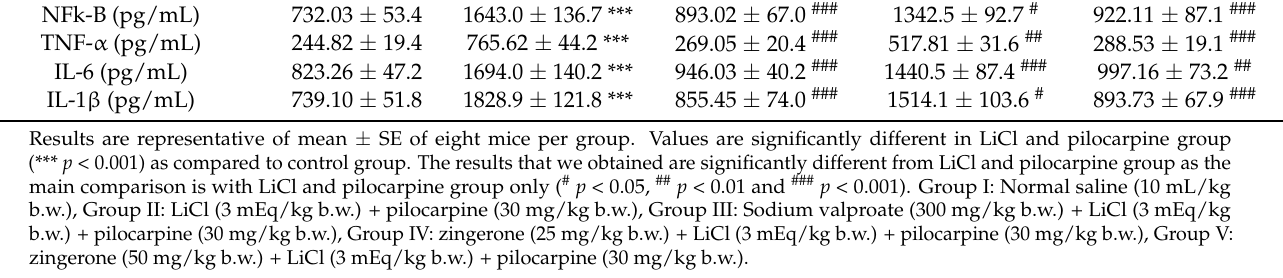
Table 3. Zingerone treatment effects on inflammatory markers on LiCl-and-pilocarpine-induced SE in experimental mice. Inflammatory